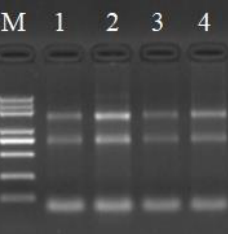
Figure 5. Total RNA extracted from different tissues of Jingyuan chicken. Note: M indicates Trans 2K Plus markers, 1–4 were diluted three times from the stock solution, and 1 µL was loaded; 1 and 2 represent the breast muscles, and 3 and 4 represent the leg muscles.